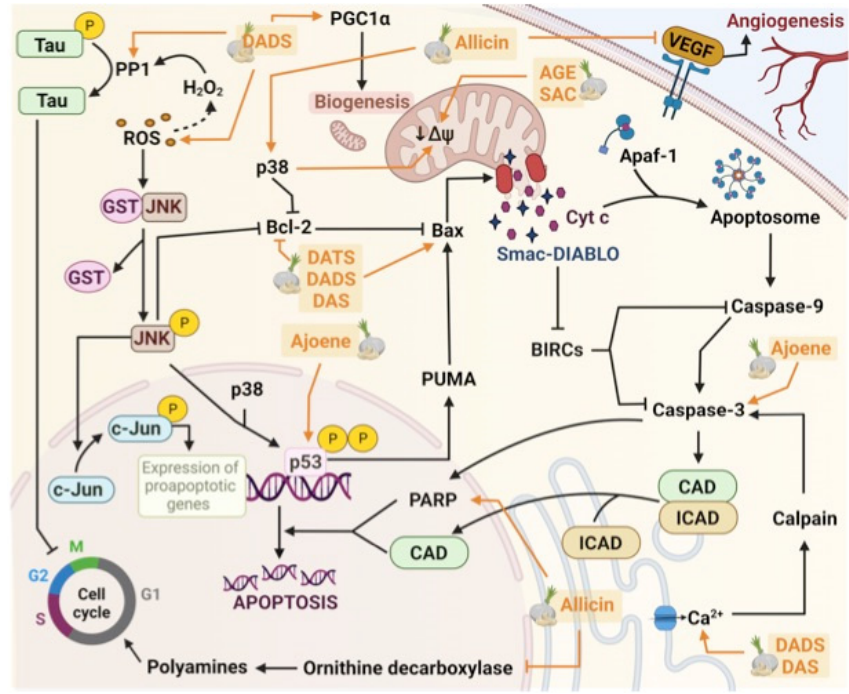
Figure 2. Schematic diagram of the molecular mechanisms of the effects of organosulfur compounds of garlic on the neuroblastoma.